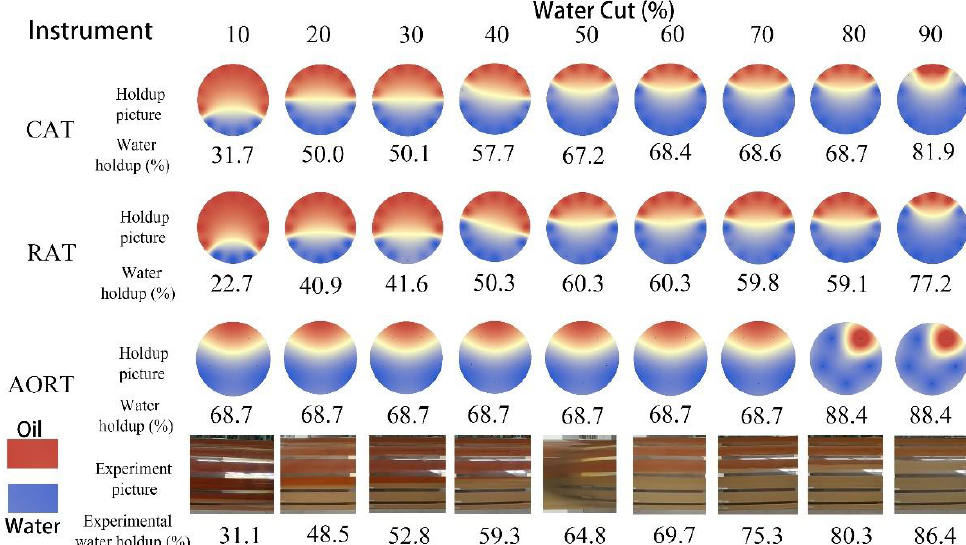
Figure 8. Comparison of interpolation imaging under different water cut conditions of 30 m 3 /d of oil and water.